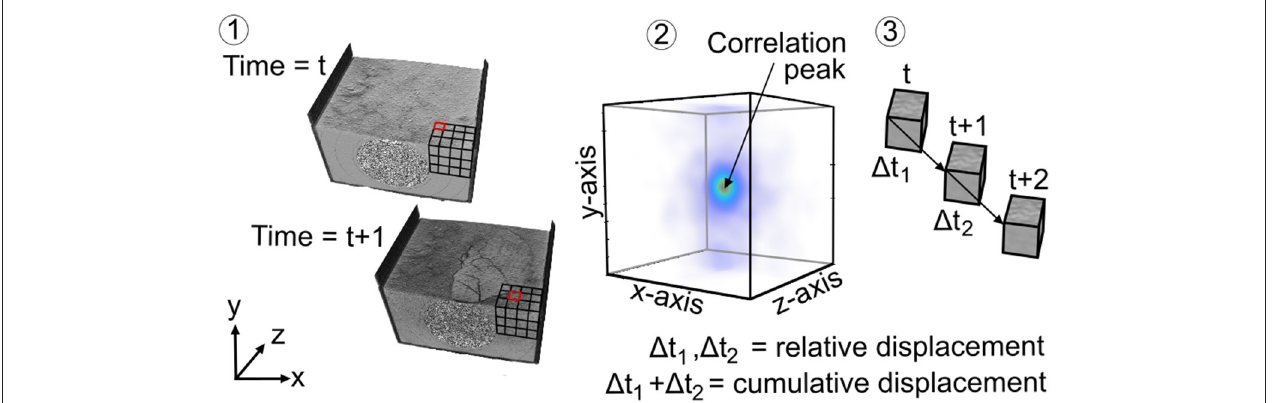
FIGURE 3 | The quantification of model deformation using Digital Volume Correlation (DVC) occurs in three steps. In step 1 voxel data of a time series of CT scans of a deforming experiment are subdivided in subvolumes consisting of a predefined number of voxels. In step 2a pattern correlation peak is determined through a direct 3D correlation function that does not require tracking individual particles. In step 3 differential vector fields are calculated for each consecutive time step; the differential vector fields can be optionally summed up to obtain the cumulative displacement.